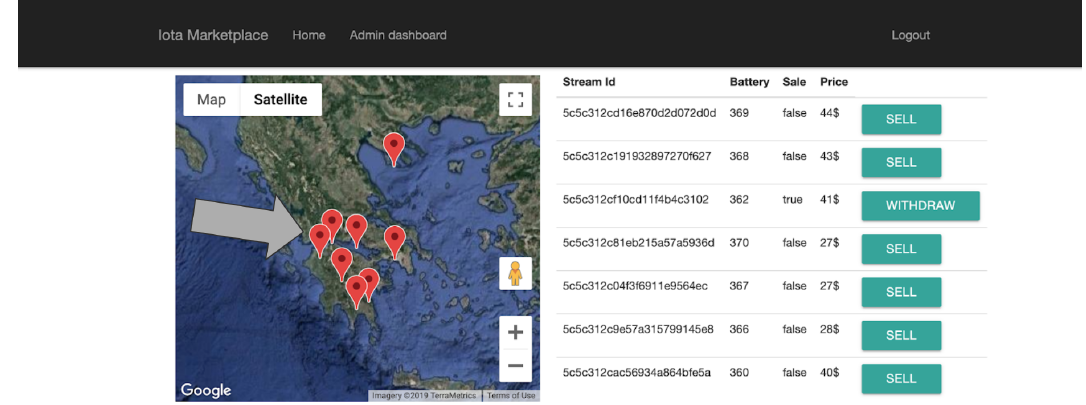
Figure 20. Data View.